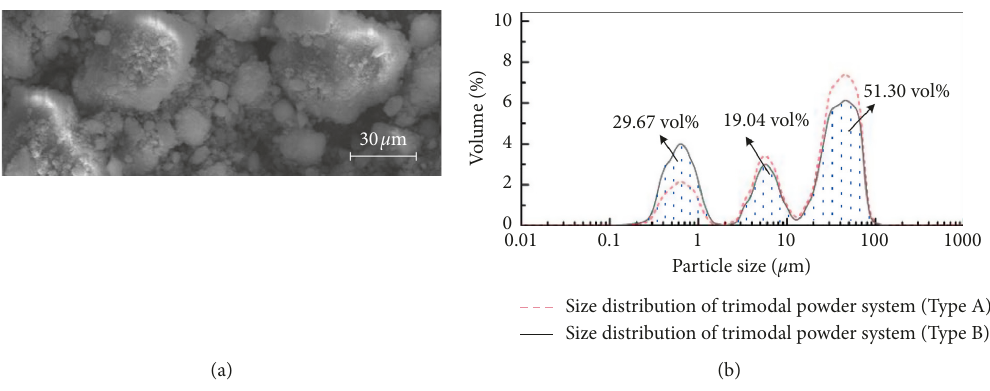
Figure 9: Prepared powder material. (a) Microscopic morphology. (b) Size distribution.